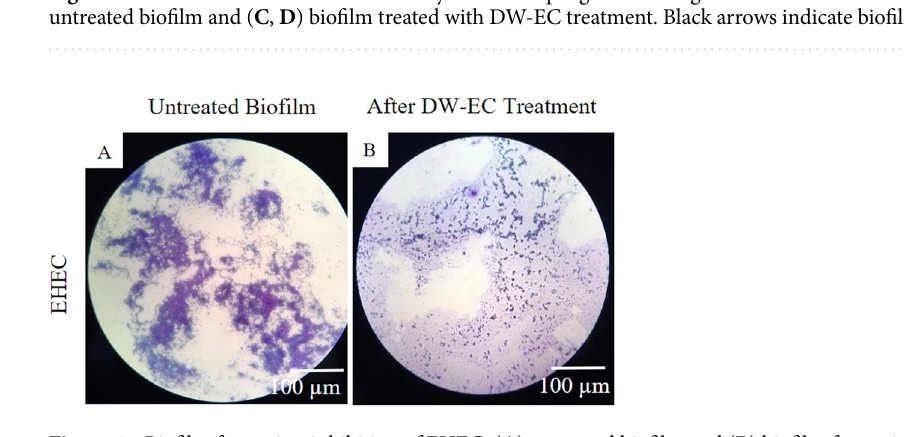
Figure 4. Biofilm formation inhibition of EHEC: ( A ) untreated biofilm and ( B ) biofilm formation treated with bacteriophage DW-EC. Magnification: 400 ×